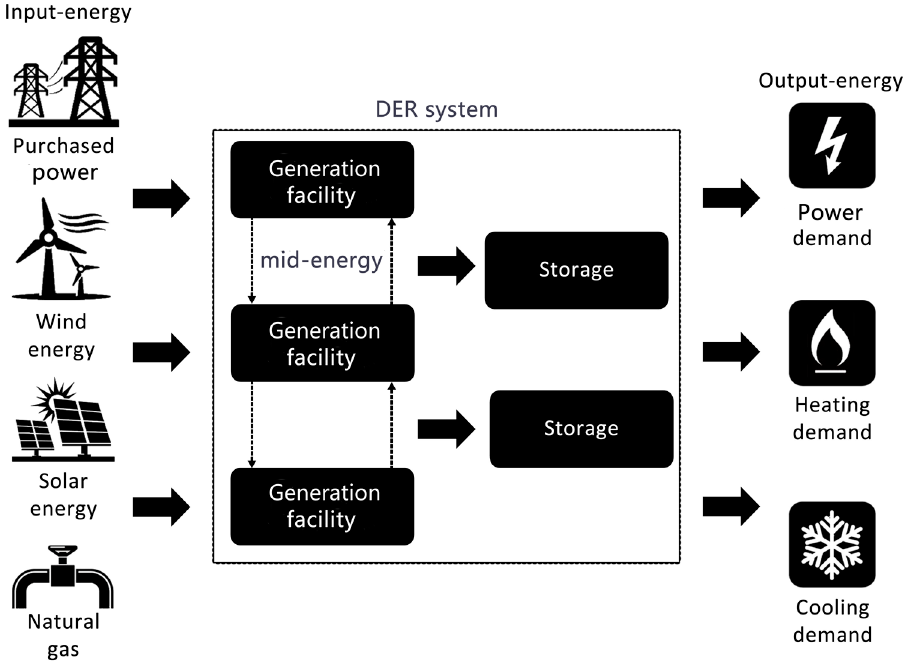
Figure 1. Superstructure of a DER (distributed energy resource) system.